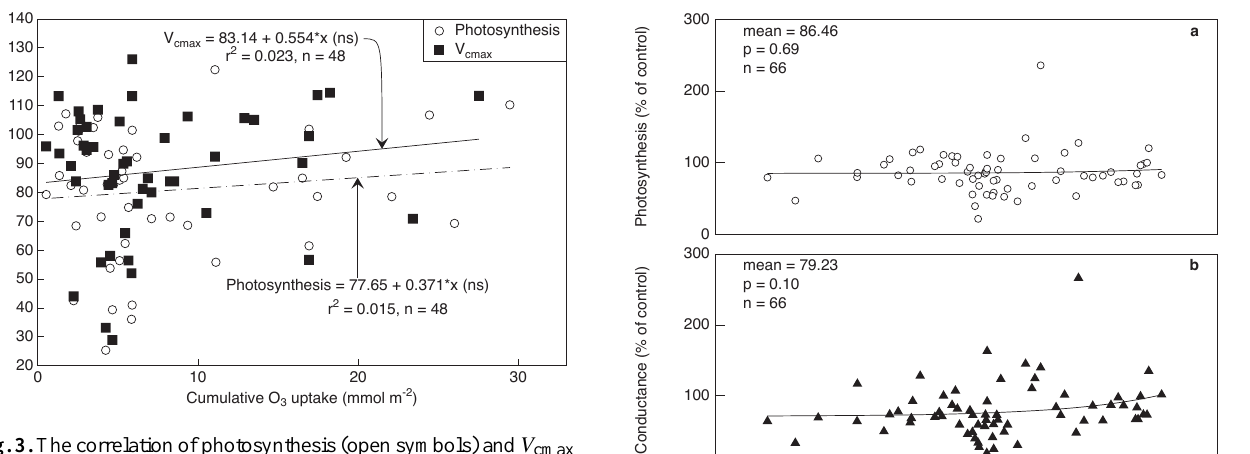
Fig. 3. The correlation of photosynthesis (open symbols) and V cmax (closed symbols) to CUO from all studies that included information for both variables. Response values are reported as % of control (treatment/control).